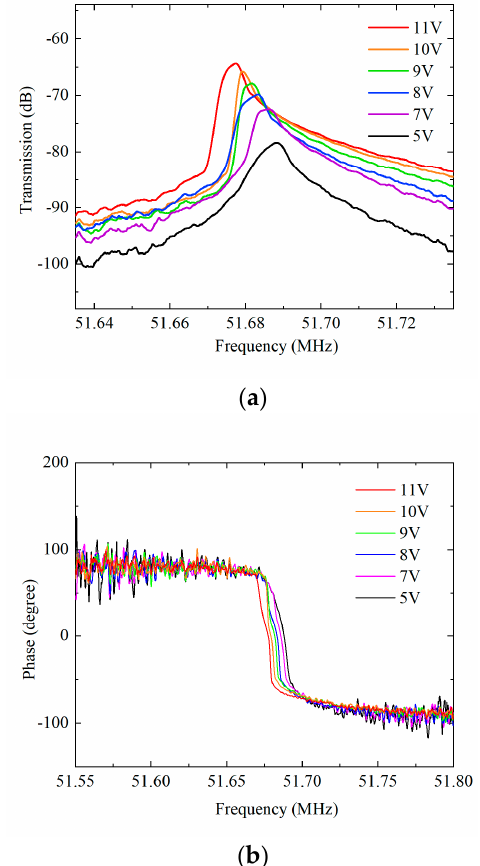
Figure 8. The frequency responses of Lamé-mode resonator operating in atmosphere under different bias voltage in transmission amplitude ( a ) and phase ( b ).